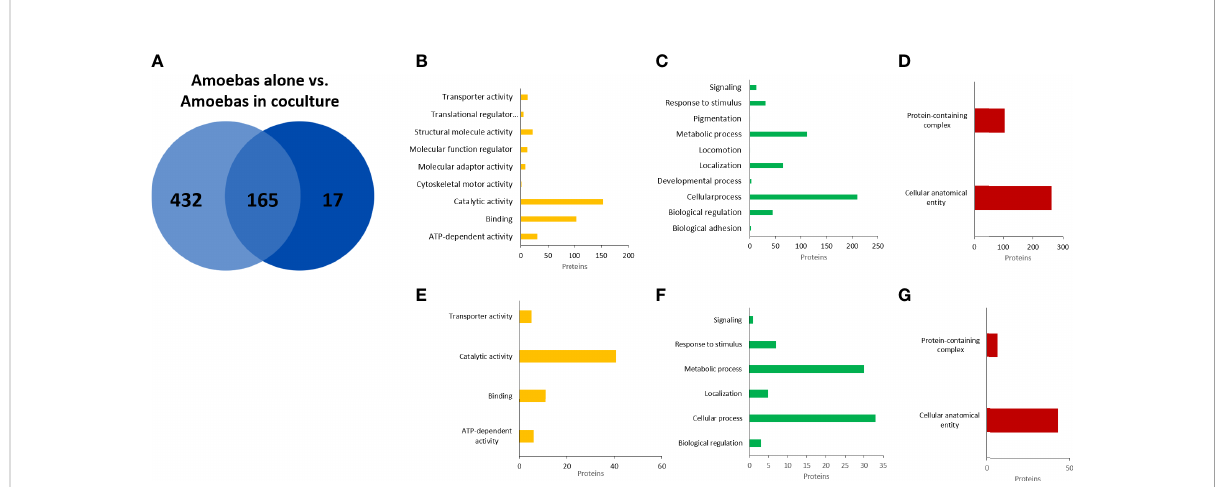
FIGURE 6 Proteomic analysis of EVs released from E. histolytica trophozoites. Venn diagram of comparted proteins between amoebae culture alone and amoebae cocultured with neutrophils (A) . Gene ontology (GO) analysis performed in PANTHER GO of molecular function (B) , biological processes (C) , and cellular components (D) of EVs proteins from amoebas alone. (E – G) , similar analysis of EVs proteins from amoebas in